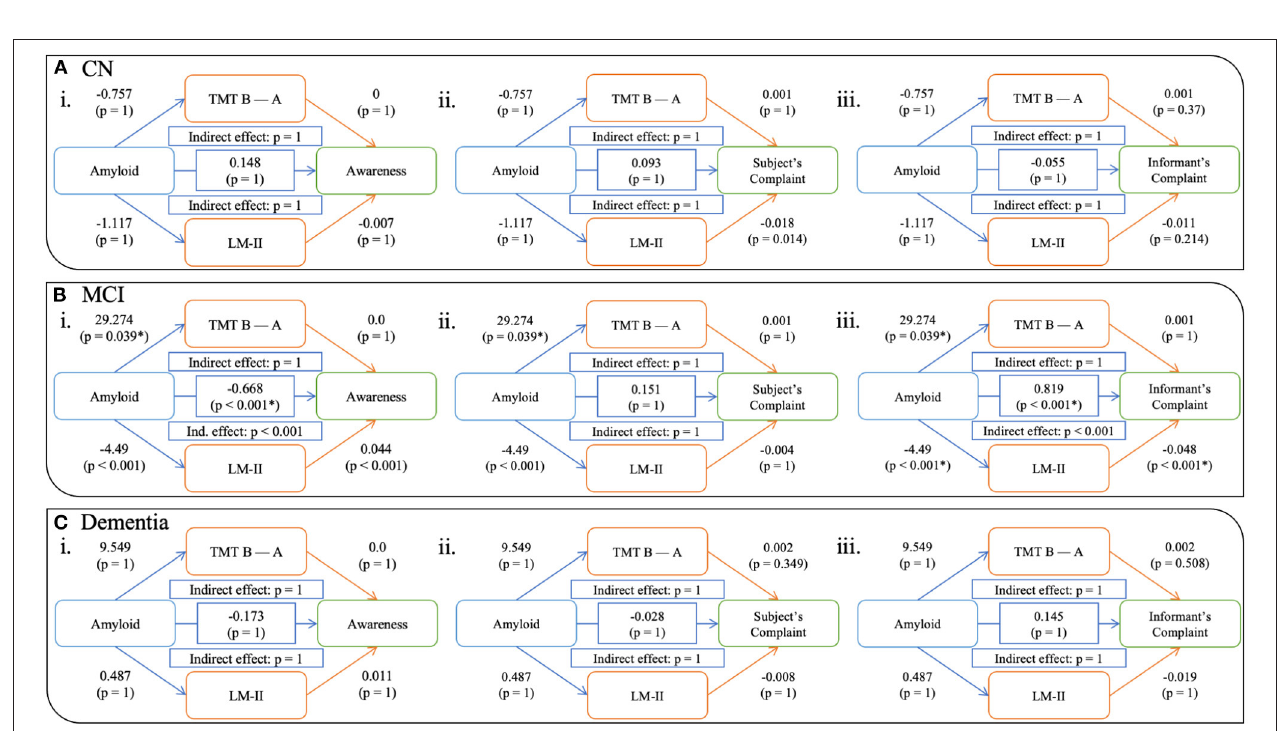
FIGURE 3 | Models showing the mediation of EM and EF on the relationship between amyloid and awareness (i), subjective complaints (ii), and informant’s complaints (iii) in CN (A) , MCI (B) , and dementia (C) participants. Notes: All p -values are corrected for multiple comparison. CN = Cognitively Normal, MCI = Mild Cognitive